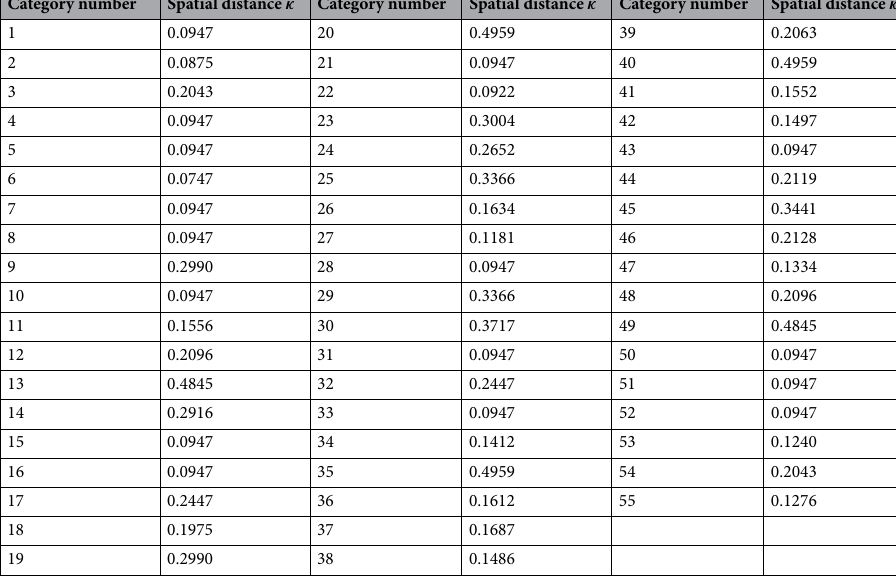
Table 4. Spatial distance statistics of influencing factor categories.